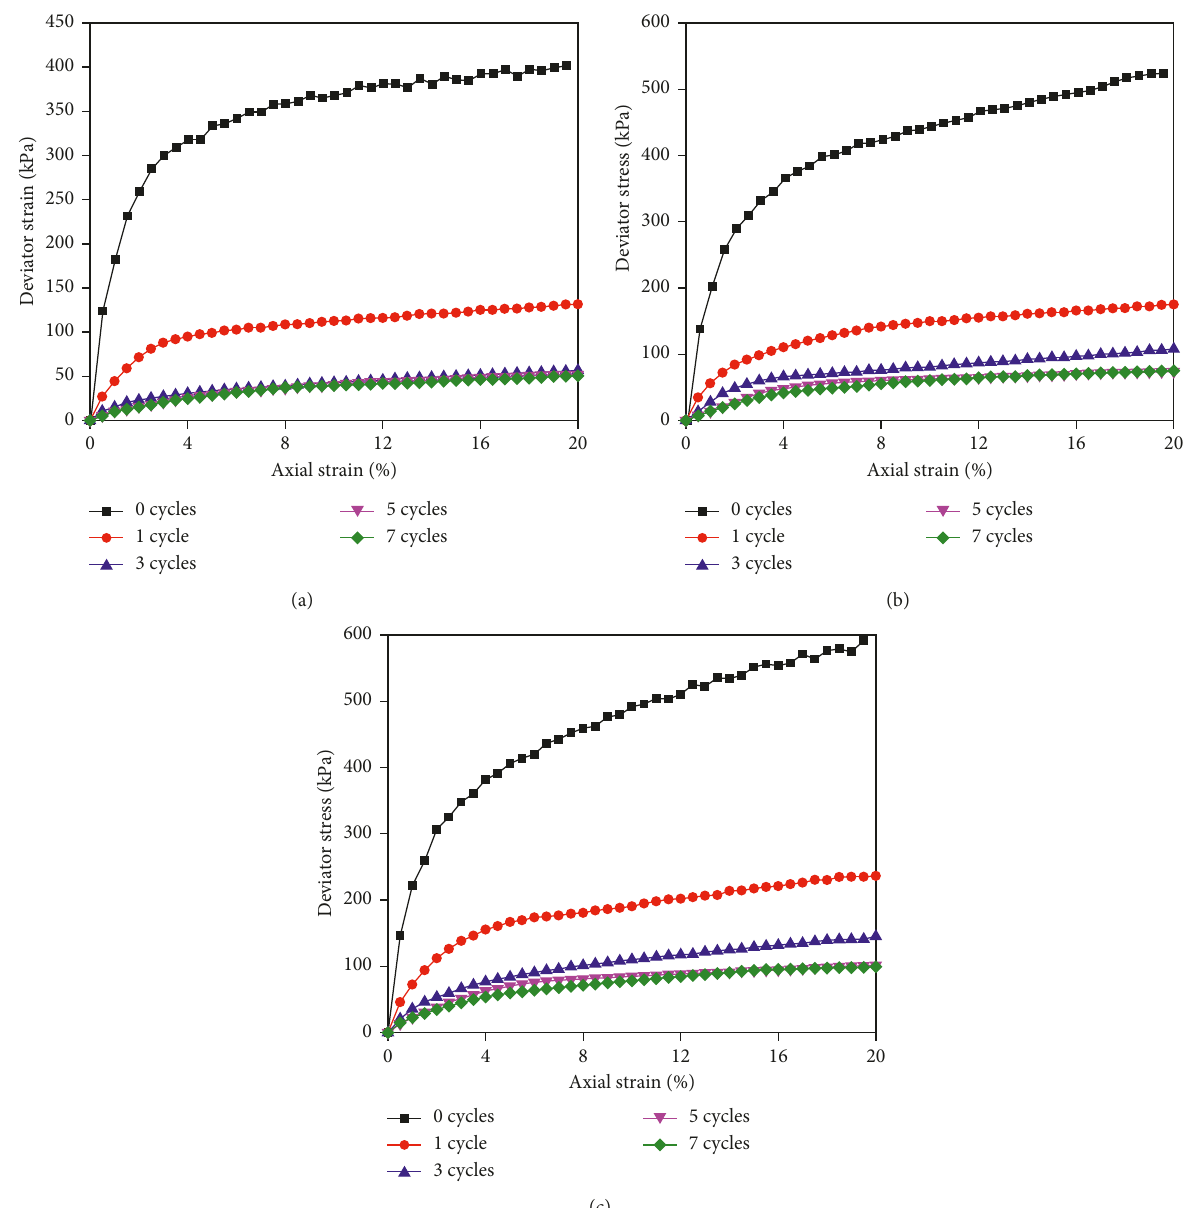
Figure 10: Deviator stress-strain curve in the open system. (a) σ